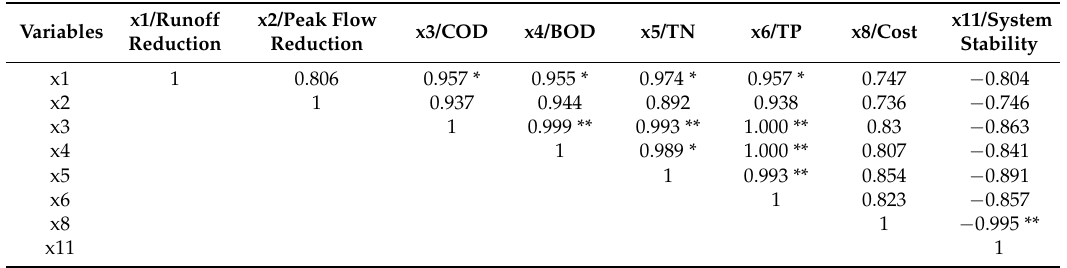
Table 7. Correlation Analysis (CA) for a first principal component of LCTIP by SPSS